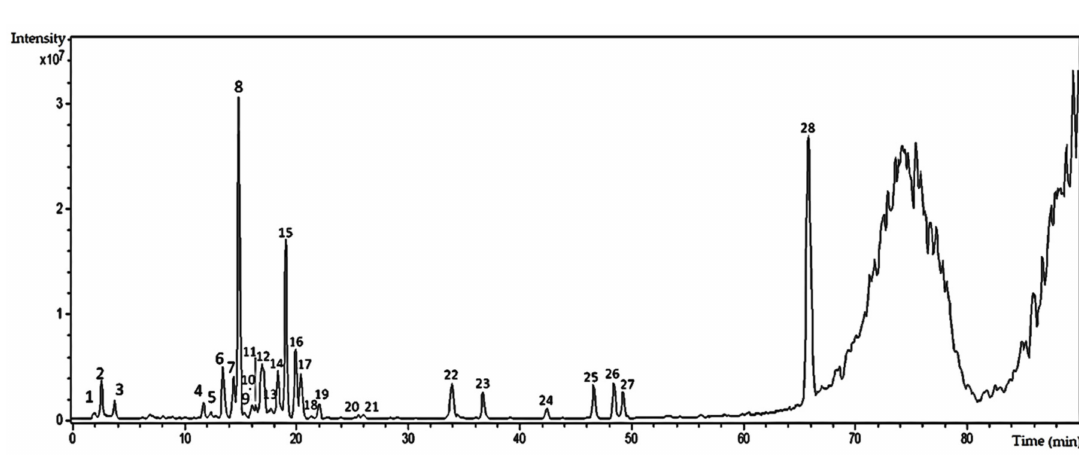
Figure 1. Chromatogram of the chemical profile of the hydroethanolic extract of T. catharinensis leaves obtained by High-Performance Liquid Chromatography (HPLC, Shimadzu LC-20AD, Shimadzu, Duisburg, Germany) with a photodiode detector (DAD, Shimadzu SPD-M20A) coupled with a mass spectrometer (micrOTOF II, Bruker Daltonics, Billerica, MA, USA) equipped with an electrospray ionization (ESI) source and a time-of-flight (TOF) type analyzer in negative mode. Experimental conditions: capillary voltage 3.2 kV, desolvation temperature 300 ◦ C, gas flow 4 L · min − 1 , and gas pressure 0.4 Bar. The spectra were analyzed using the Data Analysis software Bruker Daltonics. Nitrogen was used as a drying and nebulizing